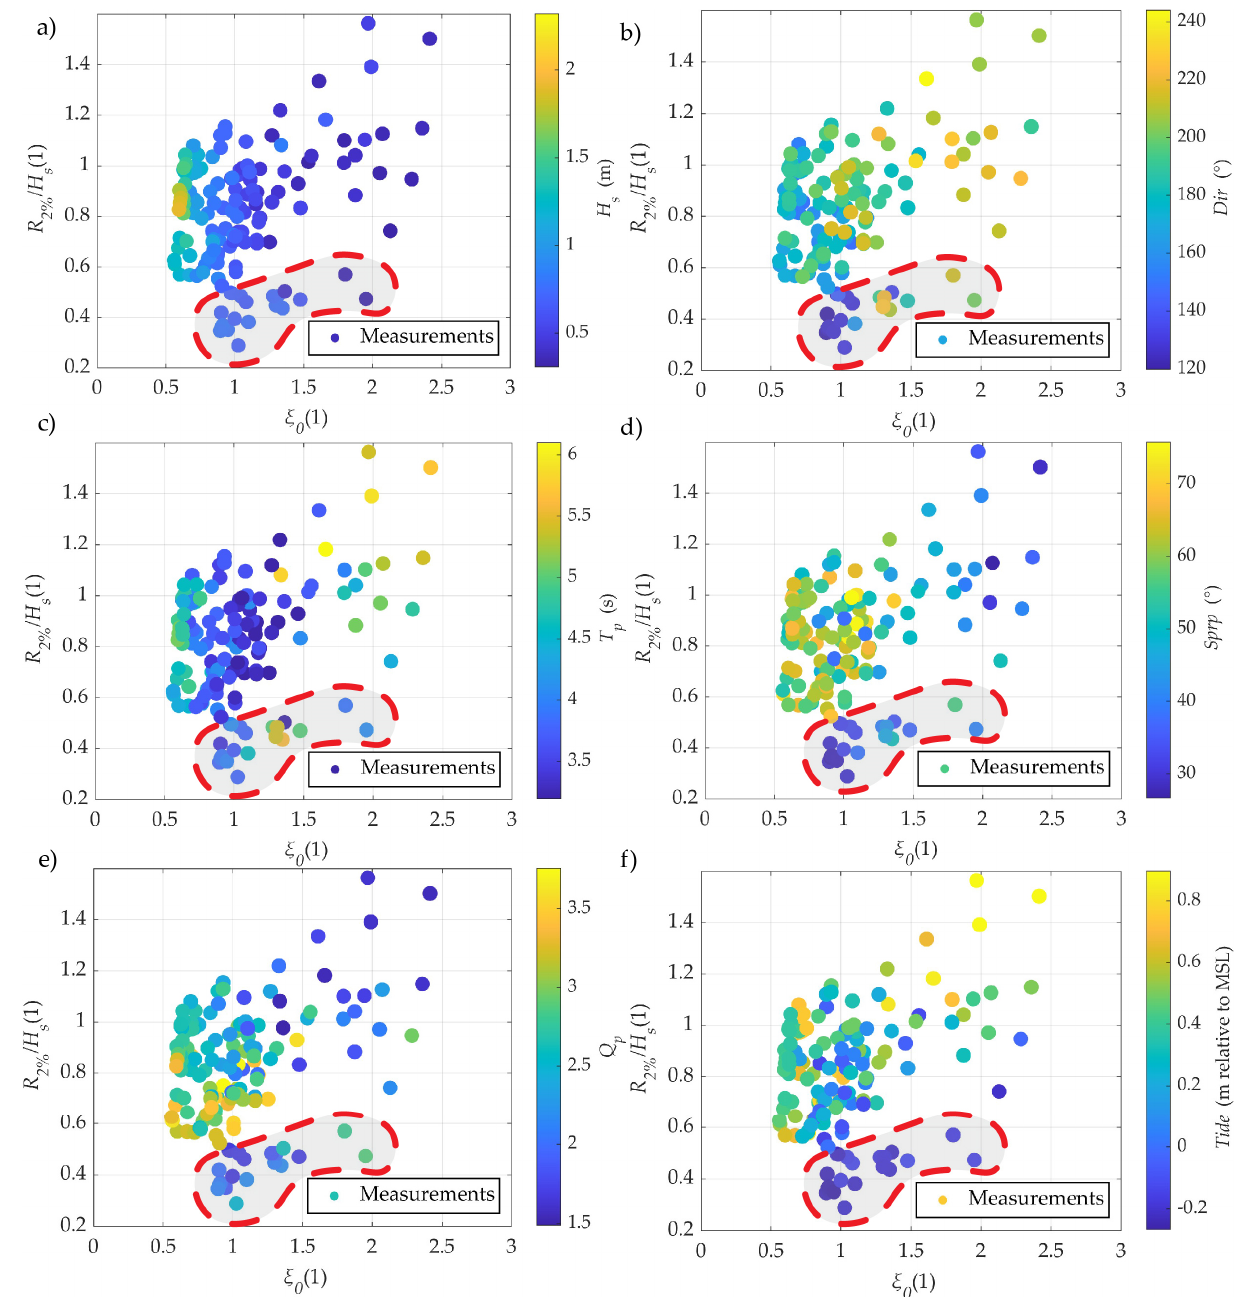
Figure 8. Scatter plots of relative run up ( R 2% / H s ) against Iribarren number ( ξ o ) with the coloring of the data points to reflect certain wave spectra parameters: ( a ) significant wave height ( H s ), ( b ) wind direction ( Dir ), ( c ) peak wave period ( T p ), ( d ) spectral spread ( Sprp ), ( e ) Goda peakedness parameter ( Q p ) and ( f ) Tide level (relative to MSL for the location); the area enclosed by a red dashed line marks a group of data points of low relative wave runup measured at low tidal levels for waves of low significant wave height, low directional wave spread and with oblique angle of incidence (see for details in Section 3.3).